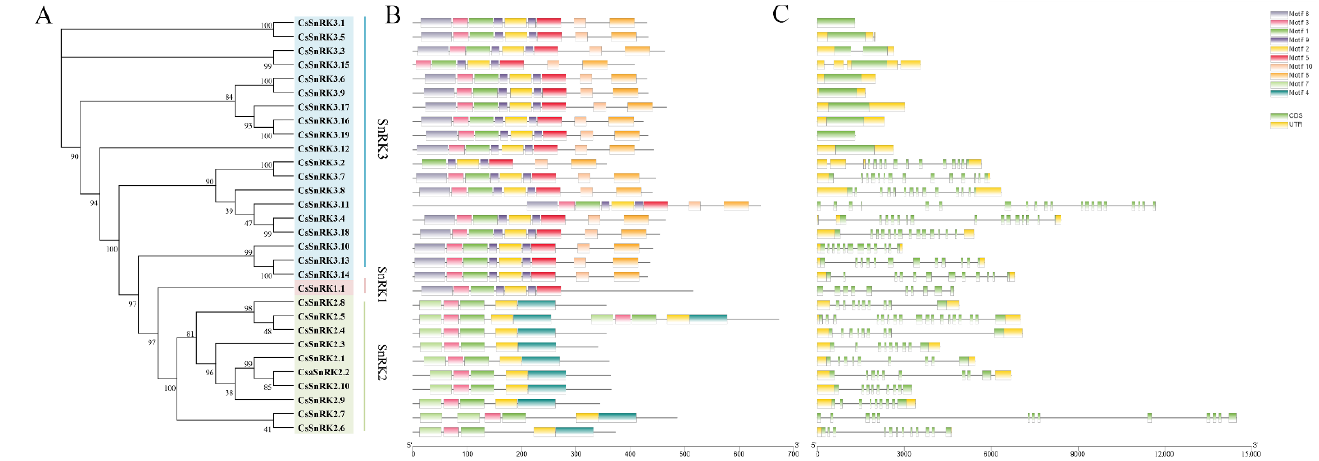
Figure 2. Phylogenetic relationships, architecture of conserved protein motifs and gene structure of CsSnRK genes. ( A ) The phylogenetic tree of 30 CsSnRK genes was built with MEGA7 choosing the NJ method. Pink, green and blue background color represents SnRK1 , SnRK2 and SnRK3 subgroups, respectively. ( B ) The motif compositions of 30 CsSnRK proteins. The motifs were identified using the MEME program. Boxes of different colors represent motif 1 to 10, respectively. The length of amino acid sequences can be estimated by the scale at the bottom. ( C ) Gene structures of 30 CsSnRK genes. Green boxes represent exons (CDS), yellow boxes represent the upstream/downstream region (UTR), and black lines represent introns. The length of nucleotide sequences of exons/introns/UTRs can be inferred by the scale at the bottom.